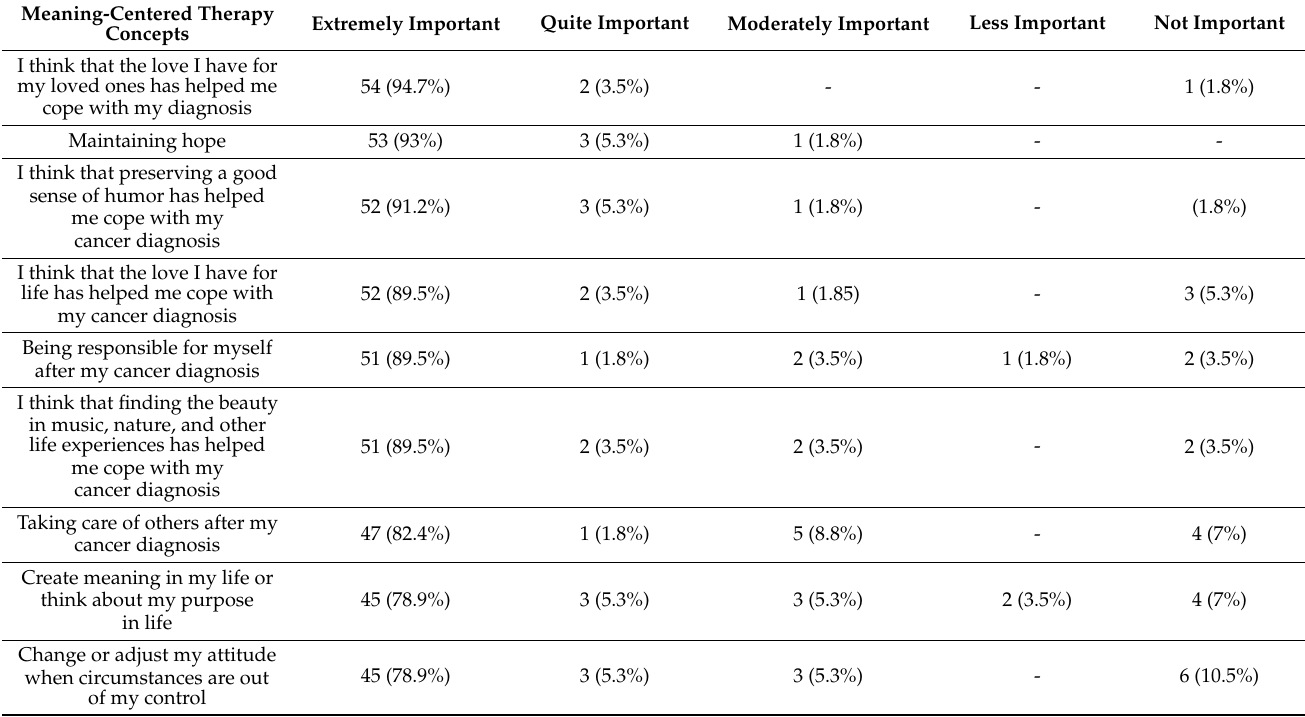
Table 4. Meaning-centered psychotherapy concepts: